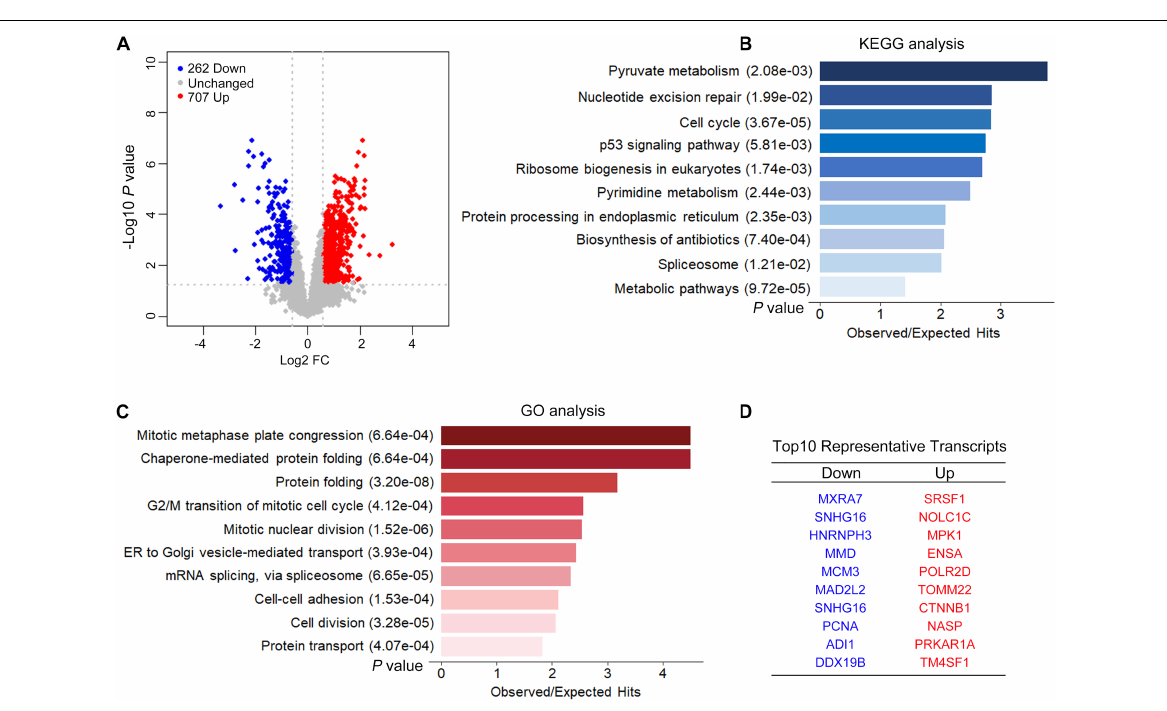
FIGURE 5 | CPSF1 knockdown induced differential expression of transcripts. (A) A volcano plot illustrates the expression of transcripts following the silencing CPSF1 in HepG2.2.15 cells. Up- and downregulated transcripts are highlighted as red and blue dots, respectively. Barplots showing the top 10 significantly enriched KEGG pathways (B) and GO biological processes (C) identified by the gene set analysis using DAVID. (D) List of top 10 representative genes down- or upregulated following CPSF1 silencing is